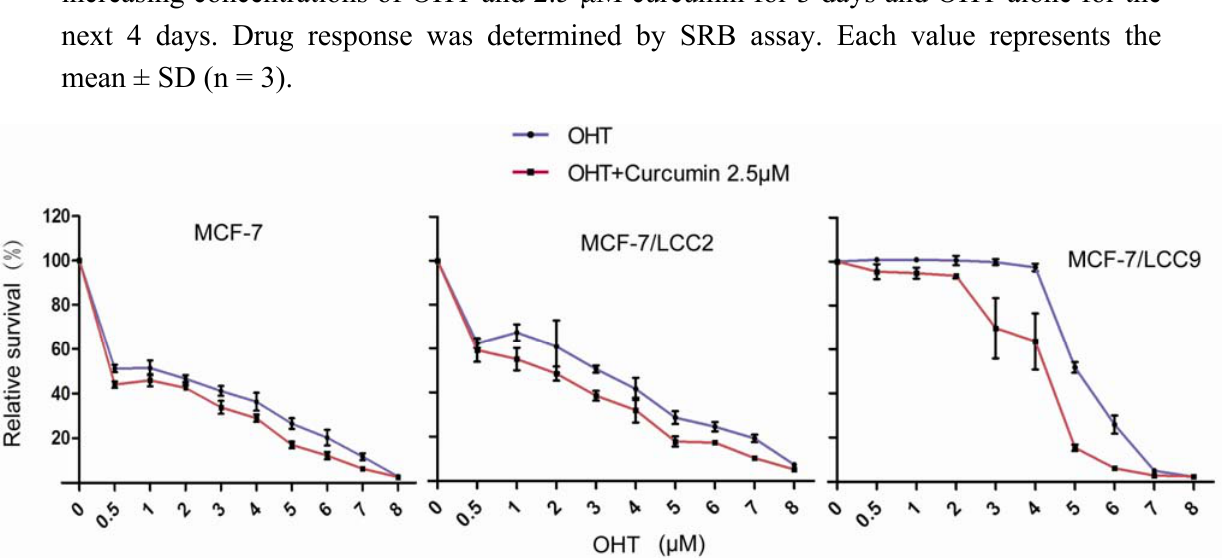
Figure 4. Curcumin enhances the sensitivity of MCF-7 and endocrine resistant cells (MCF-7/LCC2 and MCF-7/LCC9) to OHT. Cells were treated with combination of increasing concentrations of OHT and 2.5 μ M curcumin for 3 days and OHT alone for